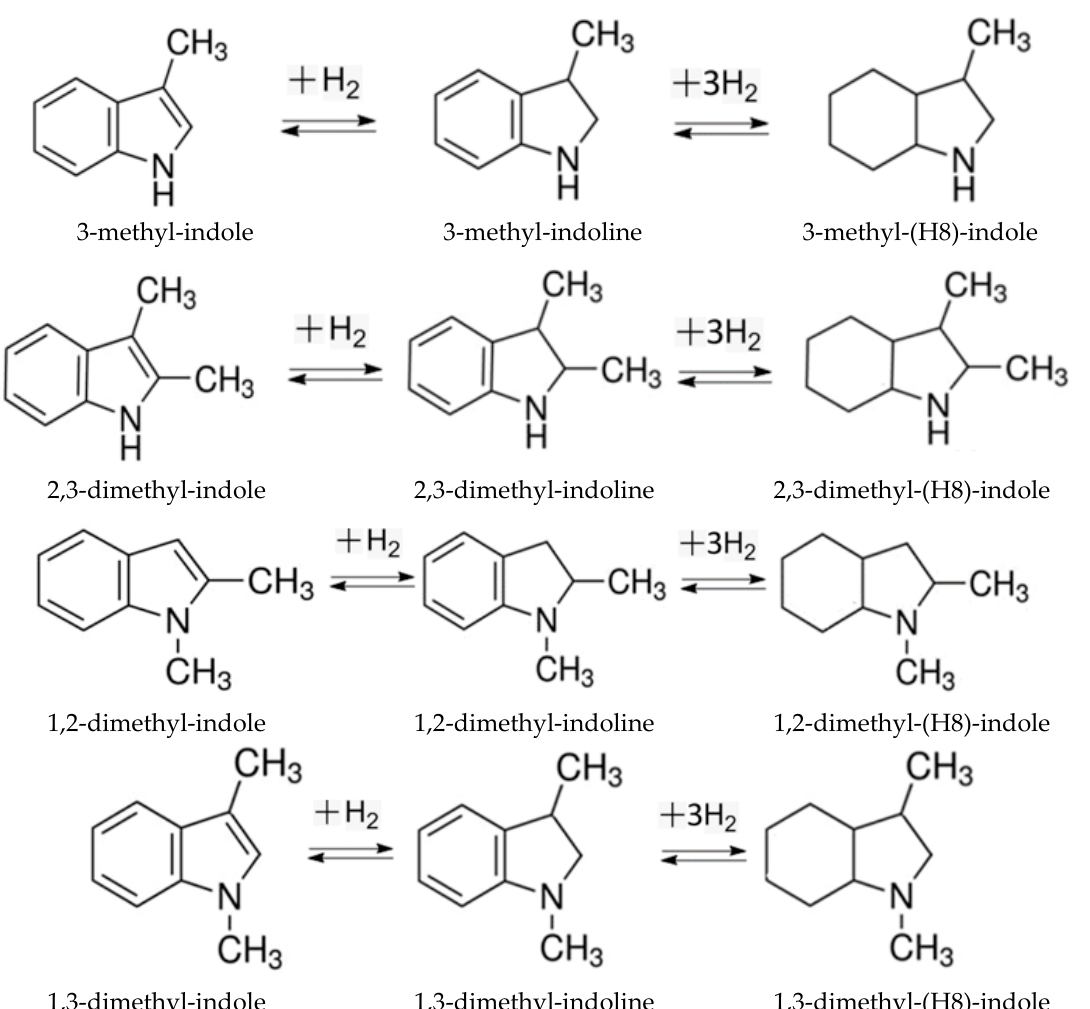
Figure 1. Reversible hydrogenation reactions in the methyl-indole-based LOHC systems studied in this work.